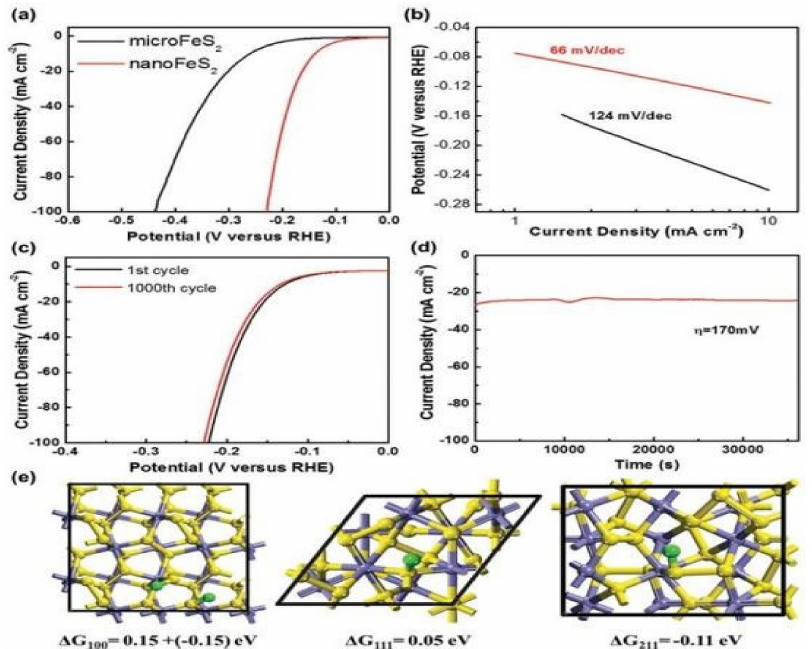
Figure 17. HER electrocatalytic performance of FeS 2 nanoparticles. ( a ) The HER polarization curves of nano-FeS 2 -RGO in comparison to micro-FeS 2 -RGO at 2 mV s − 1 in 0.5 m H 2 SO 4 . ( b ) Corresponding Tafel slopes. ( c ) Cycling stability of nano-FeS 2 -RGO after continuous potential sweeps at a scan rate of 50 mV s − 1 in 0.5 m H 2 SO 4 . ( d ) Time-dependence of the cathodic current density of nano-FeS 2 -RGO during electrolysis under a constant overpotential of 170 mV in 0.5 m H 2 SO 4 . ( e ) The configurations of hydrogen adsorption on the different FeS 2 surfaces (left (100), middle (111), and right (211)) and the corresponding free energy. In the case of (100), there are two equal S-sites for the HER process, and the free energies are 0.15 and − 0.15 eV for the first and second hydrogen. The black boxes denote the used supercells. (Reprinted with permission from reference [171]. Copyright 2017, John Wiley and